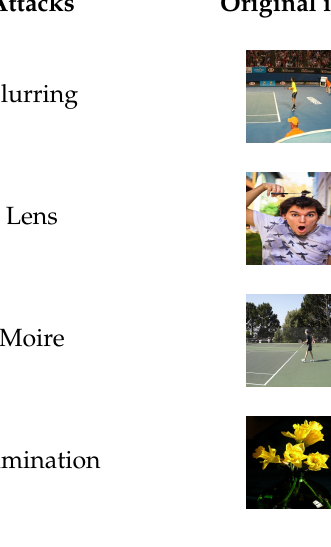
Figure 3. The distortion of the screen-shooting